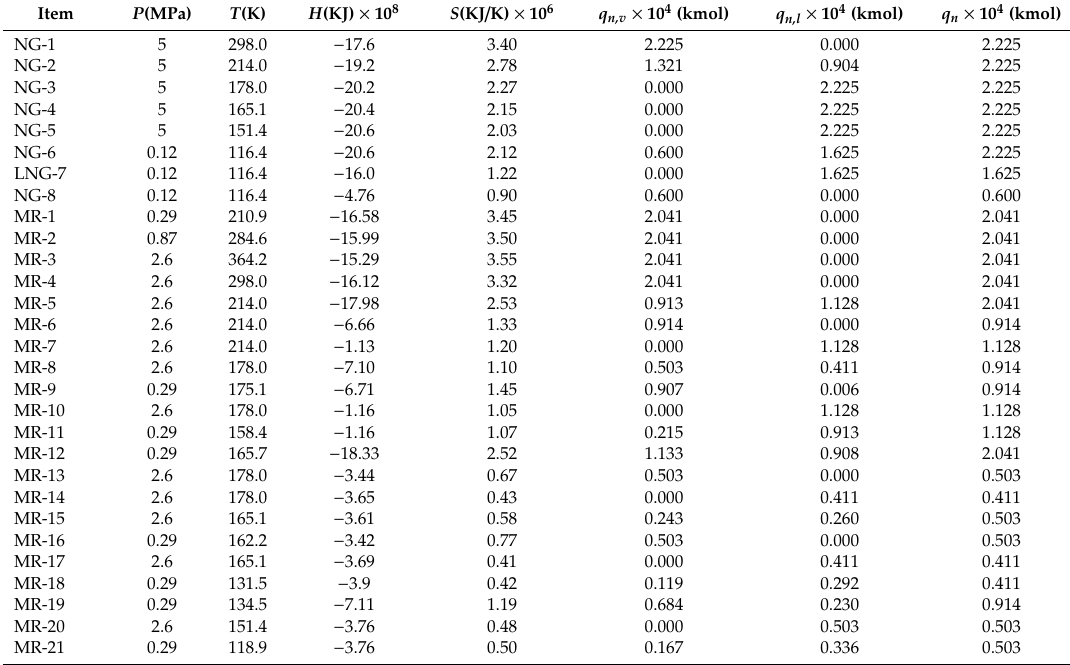
Table A1. Calculation results of the process simulation.